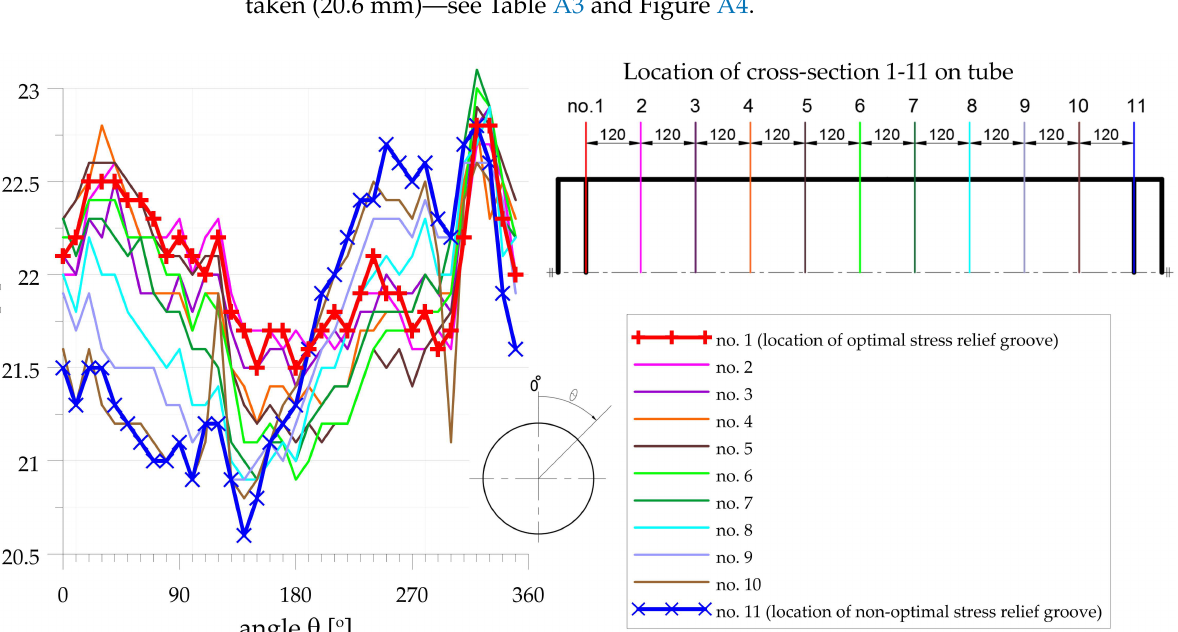
thickness are significantly different (1.3 mm for cross-section no.1 whilst 2.2 mm for cross- section no.11). Moreover, in the cross-section no.11 (welded joint with non-optimal stress relief groove) the minimal thickness has reached the lowest value of all measurements Figure A4. Measured thickness of cylindrical pipe of vessel in different cross-sections. taken (20.6 mm)—see Table A3 and Figure A4.